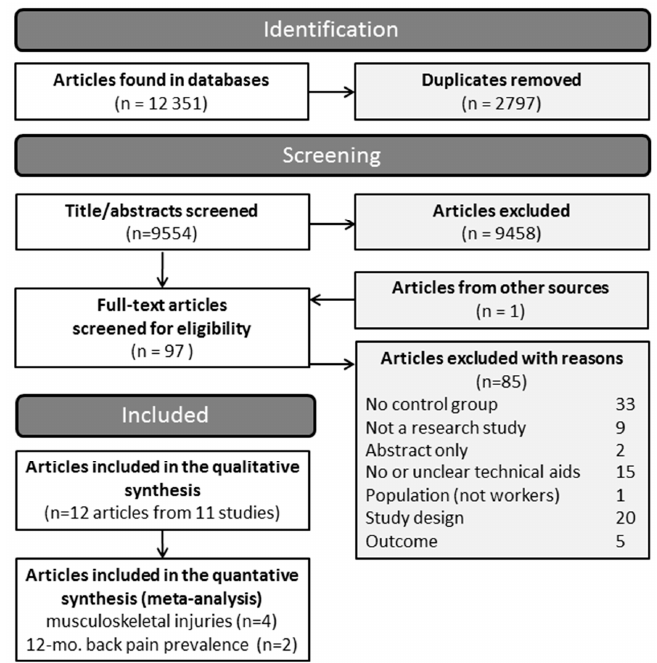
Figure 1. Flowchart depicting the literature identification process.